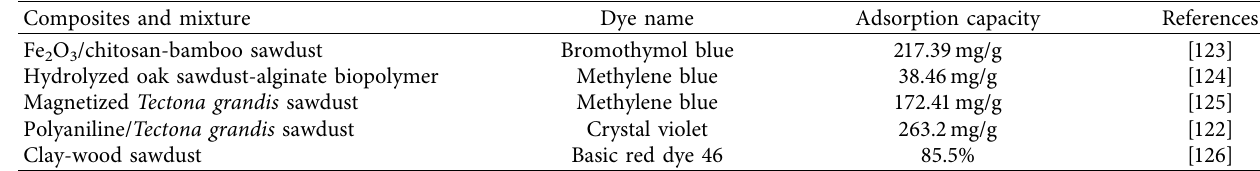
Table 8: Composites and mixture used for dyes